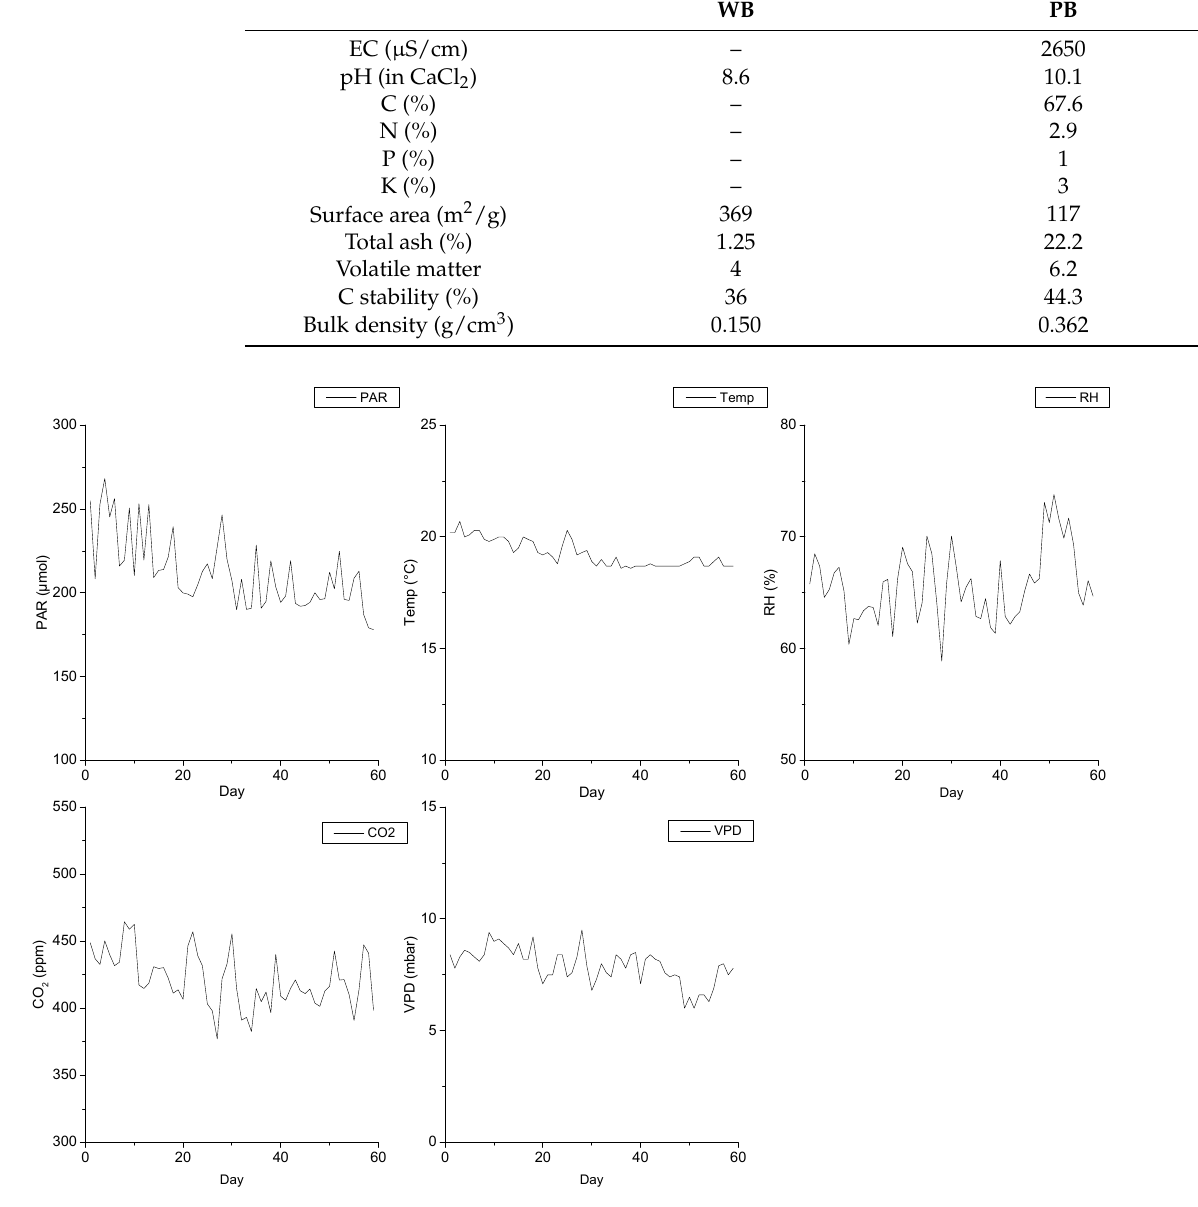
Figure 1. Cultivation environment for tomato plants. PAR, Temp, RH, CO 2 , and VPD represent photosynthetically active radiation, air temperature, relative humidity, CO 2 concentration, and vapor pressure deficit, respectively. The data were recorded from 26 October 2021 to 23 December 2021.